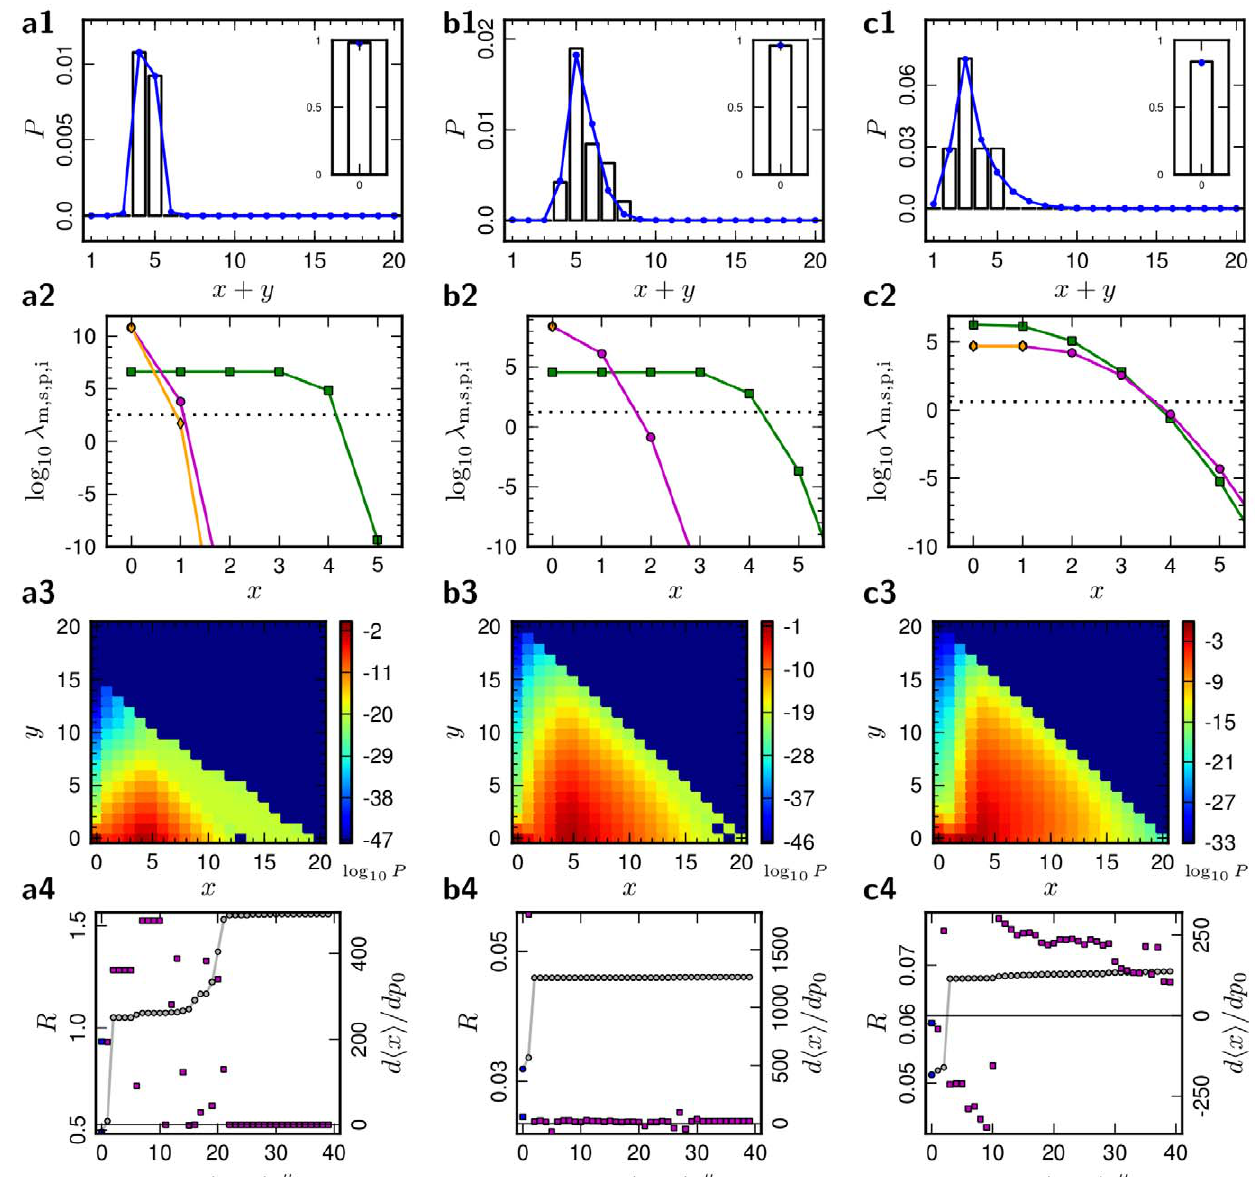
Figure 2. Single synaptic connection models. Best-fit individual models of the synaptic connections L4–L23 ( a ), L5-L5 ( b ) and L4-L4 ( c ). a1,b1,c1 (row 1): Equilibrium distributions of the total number of synaptic contacts in the structural plasticity model (blue, eq. 14) compared to reference data (black). a2,b2,c2 (row 2): Transition rate functions (7) of the models in the row 1, respectively, in units of l c . Activity dependent maturation rate l m ( x ) (green squares, eq. 8), shrinkage rate l s ( x ) (orange diamonds, eq. 9), pruning rate l p ( x ) (magenta circles, eq. 10) and intrinsic maturation, shrinkage, and pruning rate l i (dotted line). The spine creation rate l c sets the time scale and has a value of log 10 l c ~ 0 . c1,c2,c3 (row 3): Joint equilibrium distribution of the number of active ( x ) and inactive ( y ) synapses. a4,b4,c4 (row 4): Fit error ( R , gray) and derivatives of active synaptic contact number with respect to baseline correlation ( d S x T = dp 0 , magenta) for the best 40 parameter sets, ordered by error R . Blue markers indicate the model that is displayed above (rows 1 to 3). Model parameters and further information are given in Table